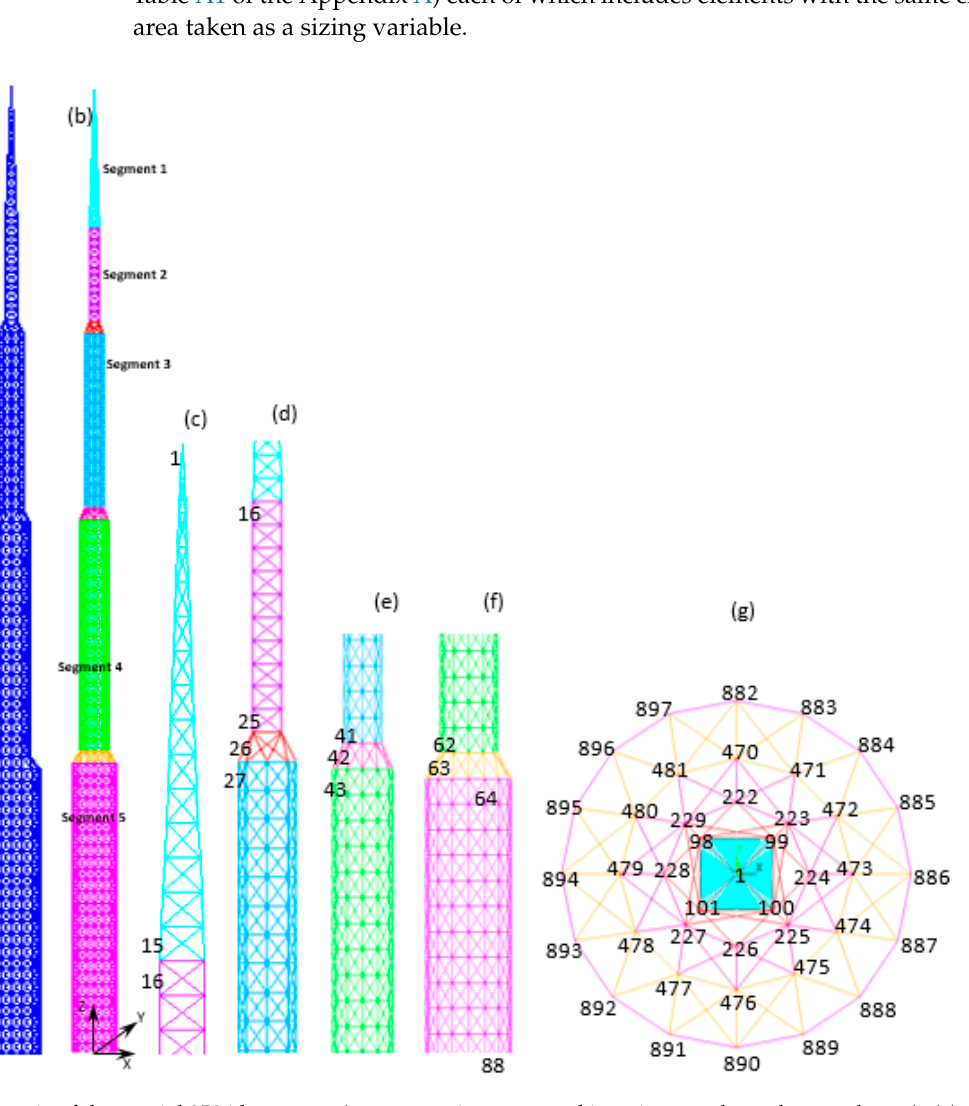
Figure 6. Schematic of the spatial 3586-bar tower (representative story and junction numbers also are shown): ( a ) Assembly view; ( b ) Color view of the five segments and three junction modules included in the structure; ( c ) Transition from the top of the tower to segment 1 (top of the structure); ( d , e ) Transitions between segments 2 and 3, and between segments 3 and 4 (center of the structure); ( f ) Transition between segments 4 and 5 (bottom of the structure); ( g ) Layout view indicating